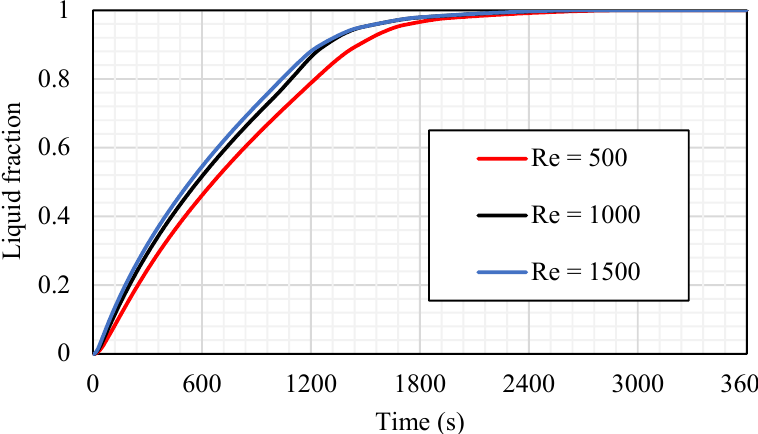
Figure 15. The liquid fraction development for the total PCM for case 3b (Tin equals 50 °C) at different values of Re (500, 1000, and 1500).